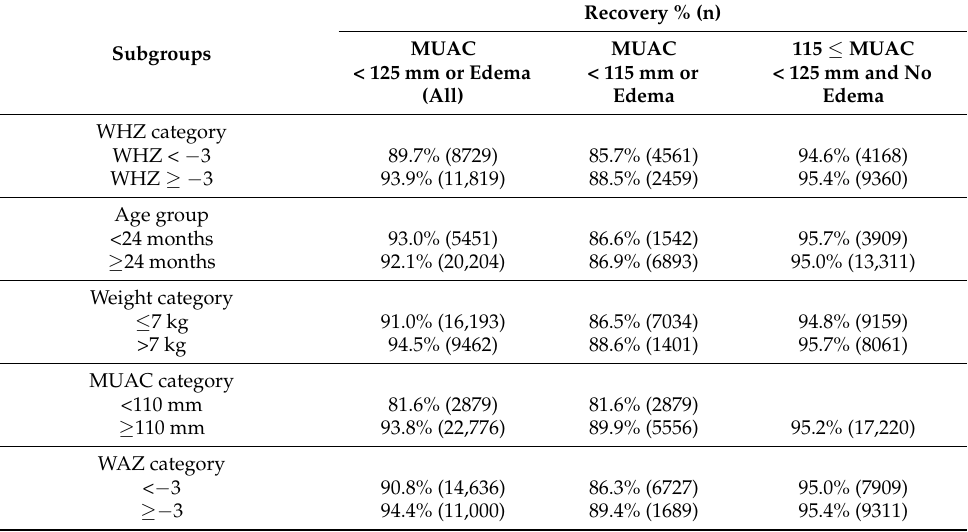
Table 4. Recovery from malnutrition in Mali following the simplified, combined treatment by